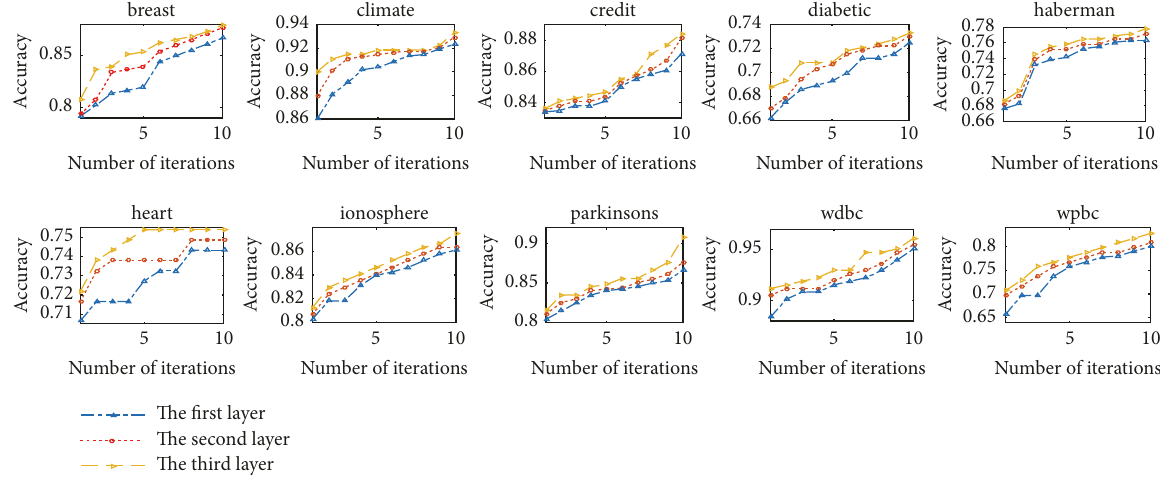
Figure 3: The classification results of the three models on the top ten iterations.